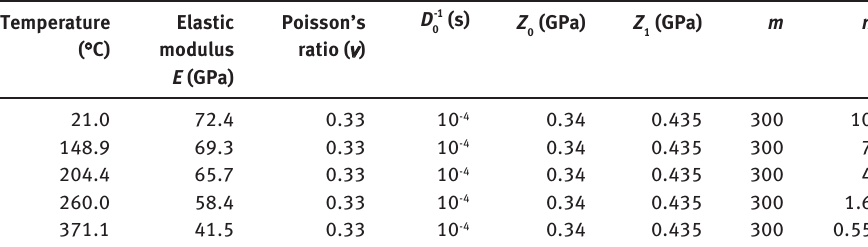
Table 2 Material parameters of the aluminum alloy (2024-T4) [13].